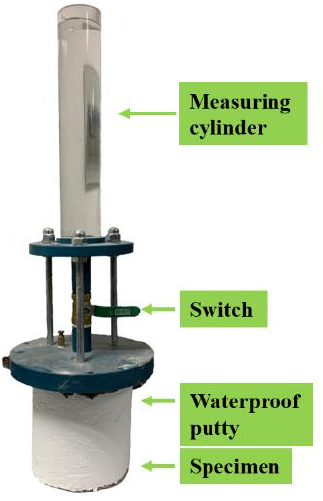
Figure 4. Installation of seepage test.